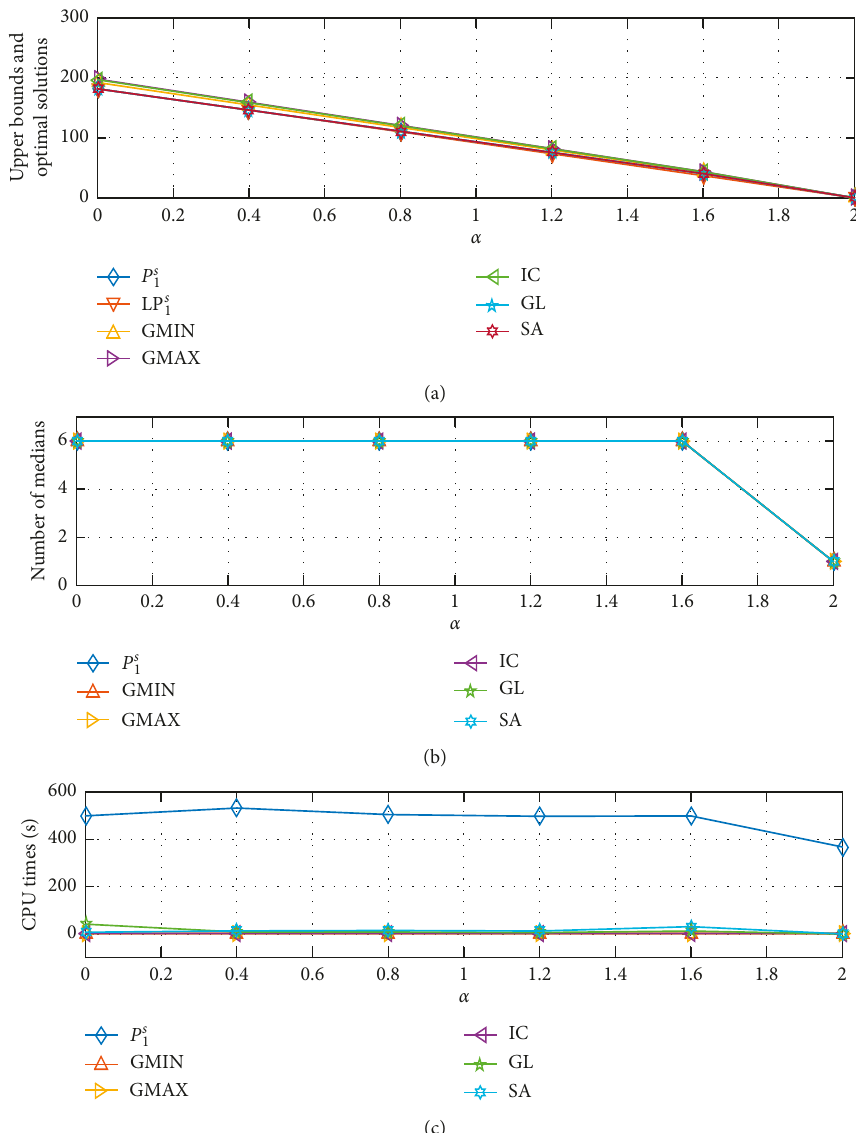
Figure 3: (a) Upper bounds and optimal solutions, (b) number of facilities, and (c) CPU times in seconds for the instance #11 in Table 1 while varying α ∈ [ 0 ; 2 ] and using a radial coverage value of 0.5